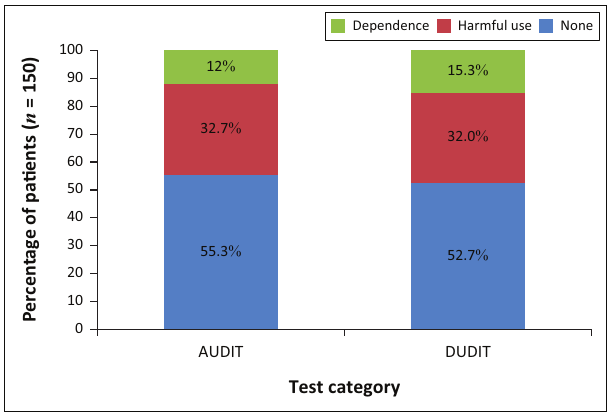
FIGURE 3: Percentage of sample in each alcohol use disorders identification test and drug use disorders identification test